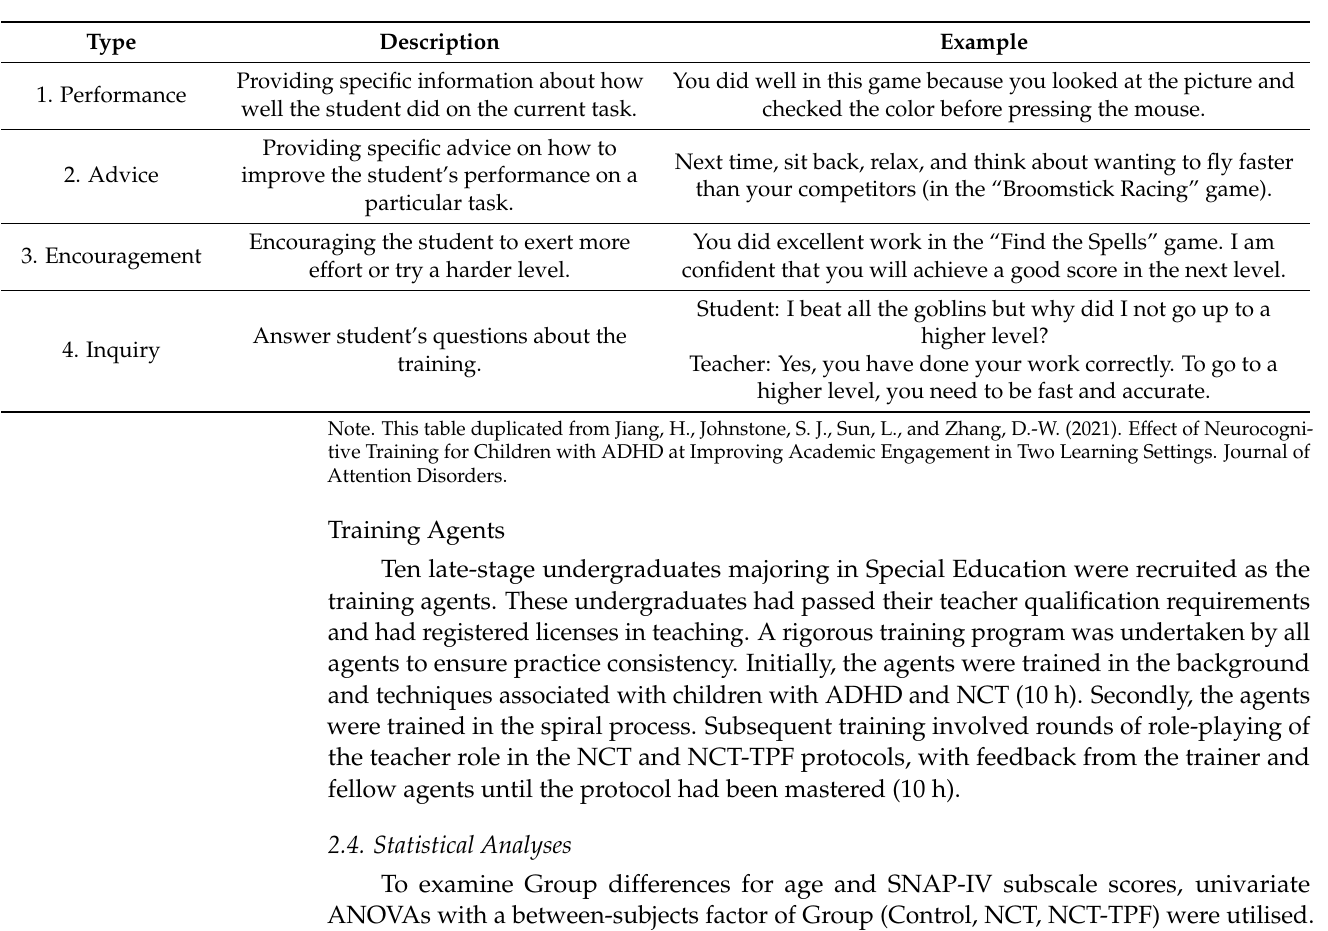
Table 2. Types and examples of teacher feedback during a neurocognitive training